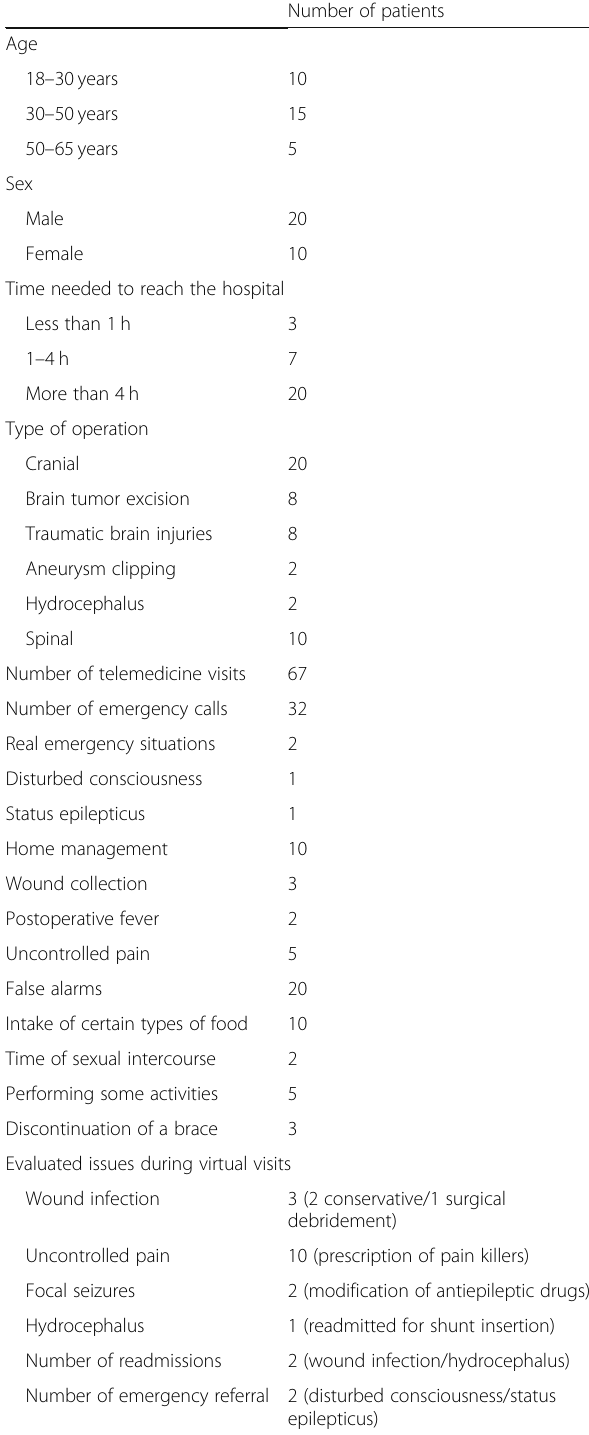
Table 3 Summary of results